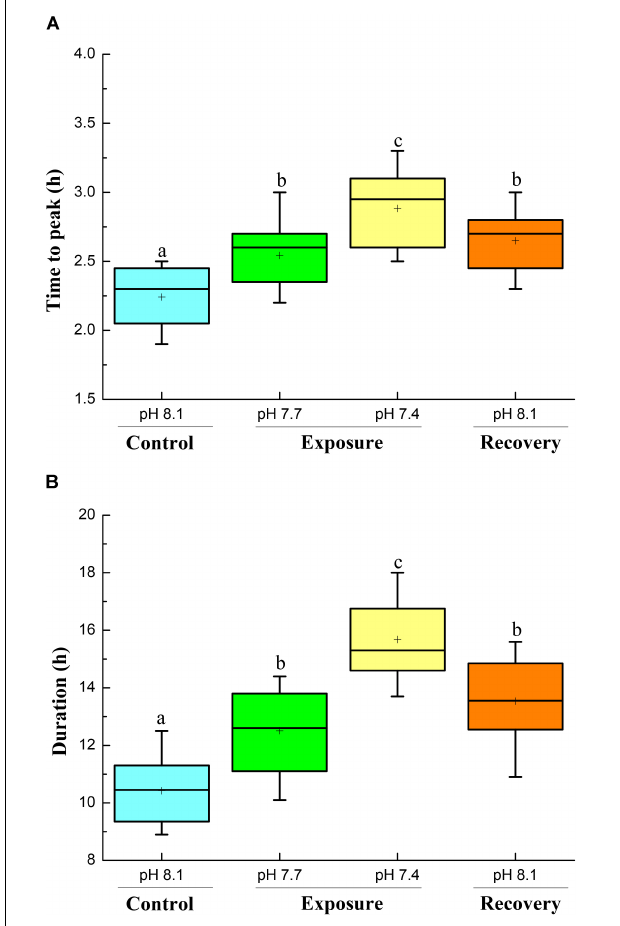
FIGURE 2 | Time to peak (A) and SDA duration (B) of C. pagurus at varying pH conditions (pH 8.1 control), pH 7.7, pH 7.4, and pH 8.1 (recovery). Data were analyzed using one-way ANOVA. Significance was reported at the P < 0.05 levels, Different letters indicate that the value was significantly different from the control pH